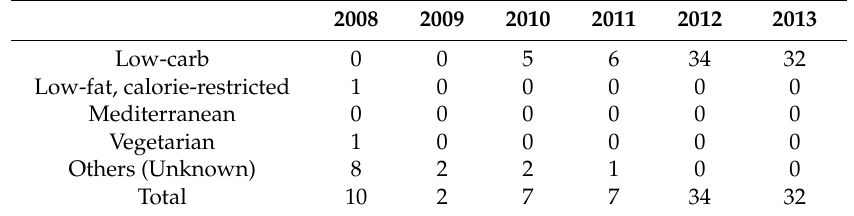
Table 3. Change in the restaurants’ attitudes regarding specific menus for people with